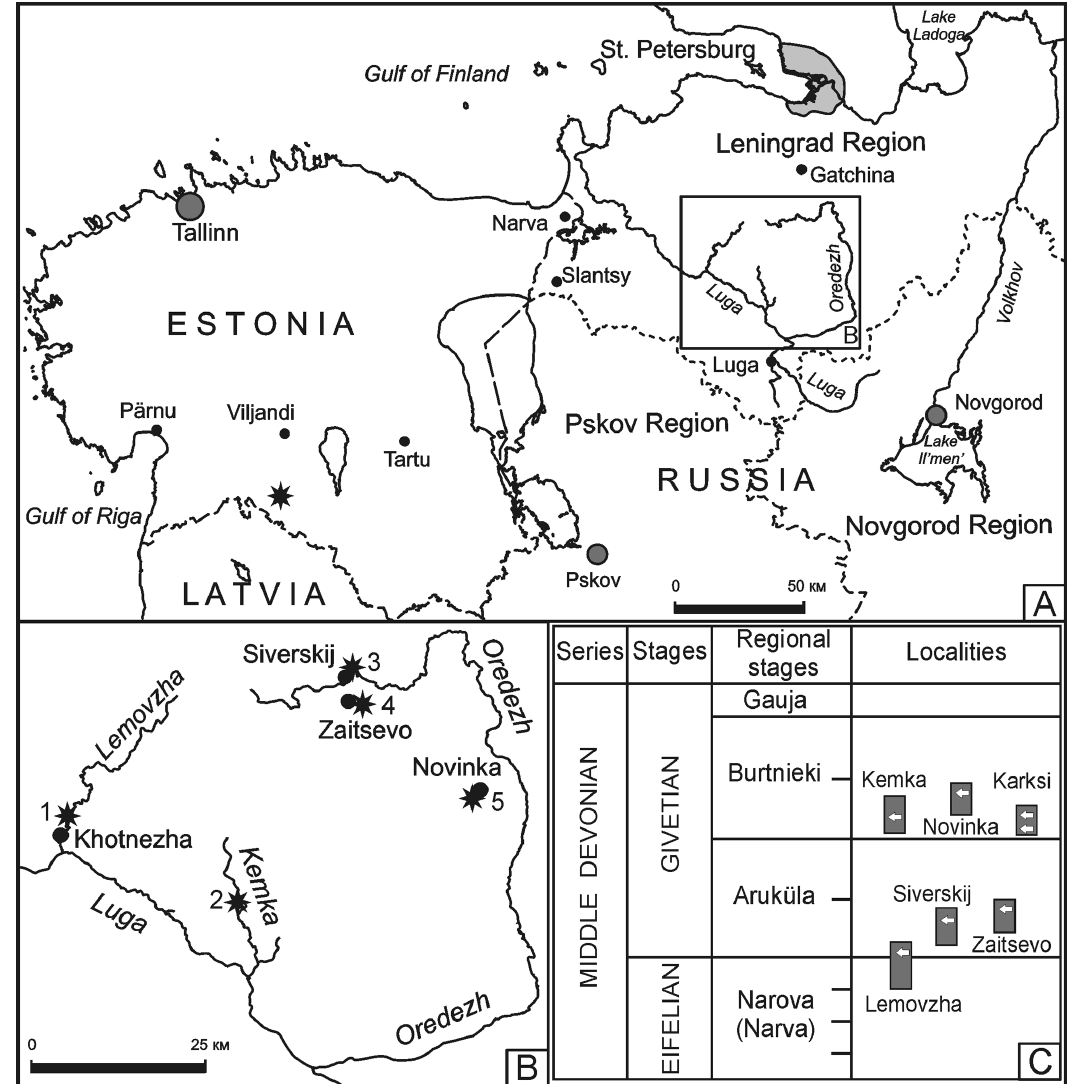
Fig. 1. A , B , location of the studied outcrops; the Karksi outcrop is shown by an asterisk in A; outcrops (localities) in the Leningrad Region are shown by asterisks in B: 1, Lemovzha; 2, Kemka; 3, Siverskij; 4, Zaitsevo; 5, Novinka. C , Stratigraphical interval of the studied outcrops (shown by grey rectangles) and levels of collected specimens (shown by a white